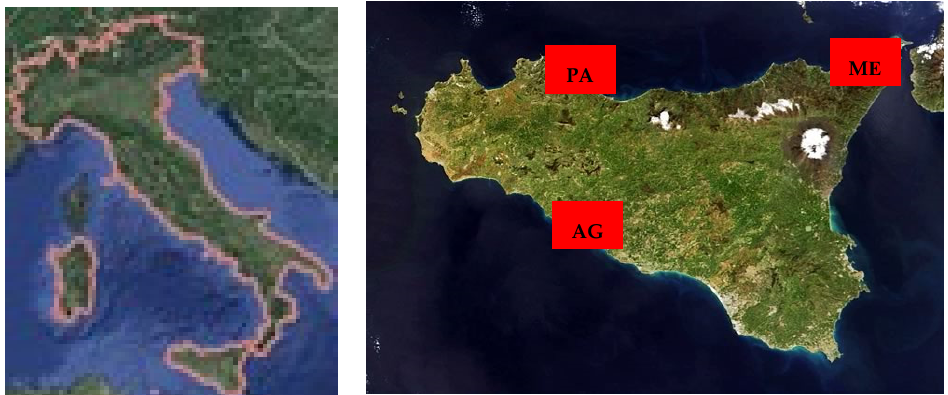
Figure 1. Sampling sites of clary sage in Sicily. Abbreviations of the provinces of origin: AG = Agrigento; ME = Messina; PA =